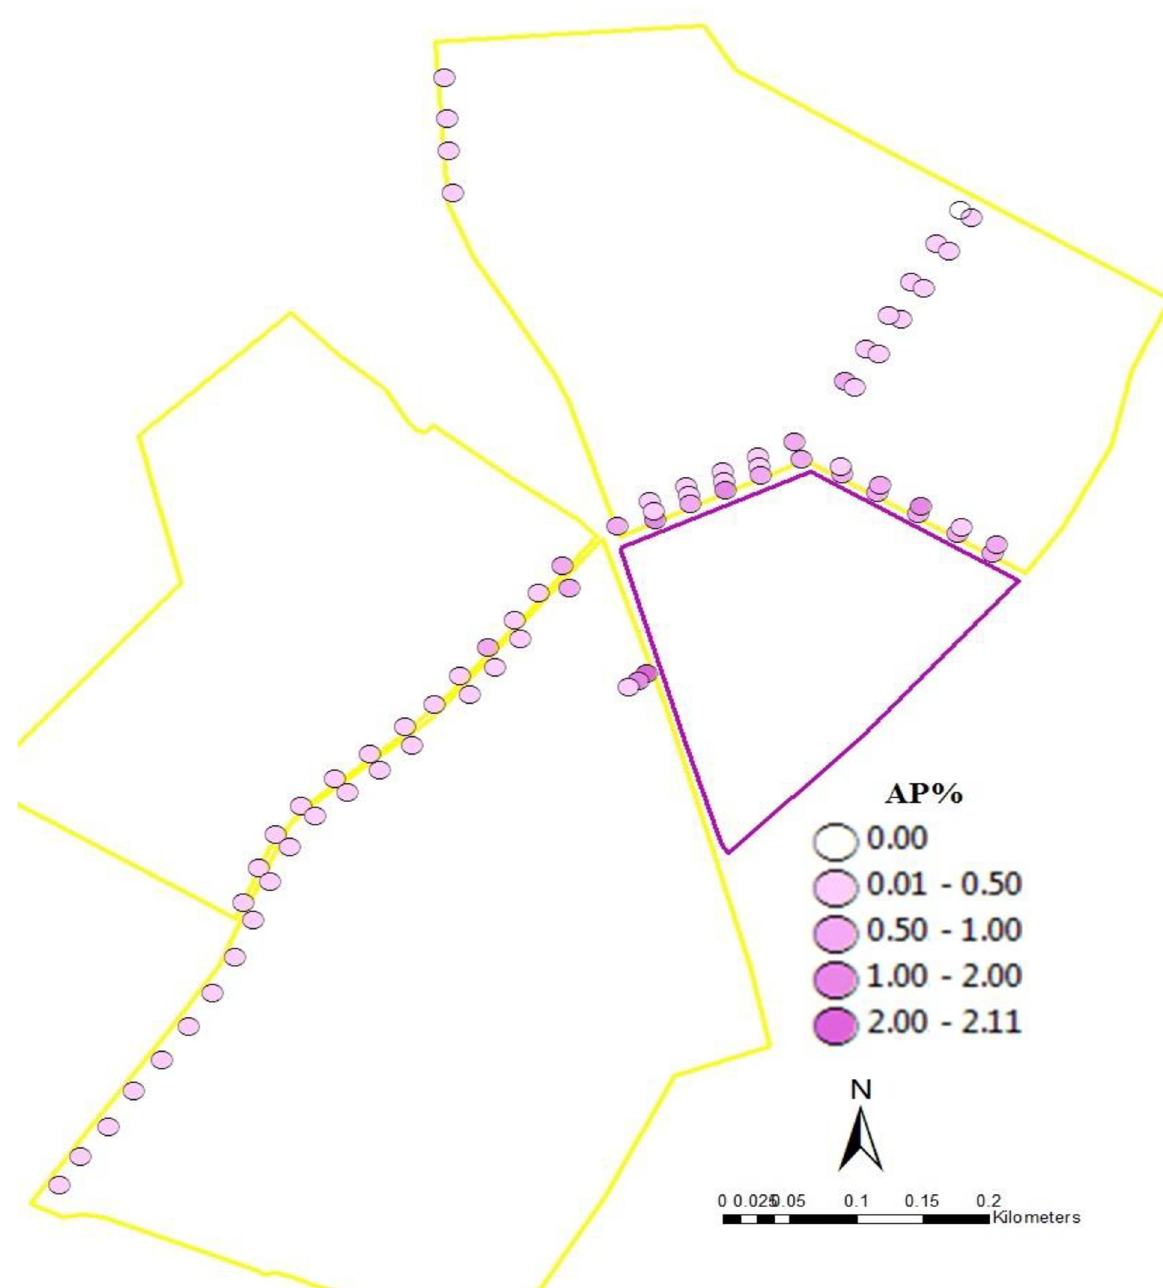
represents GE source